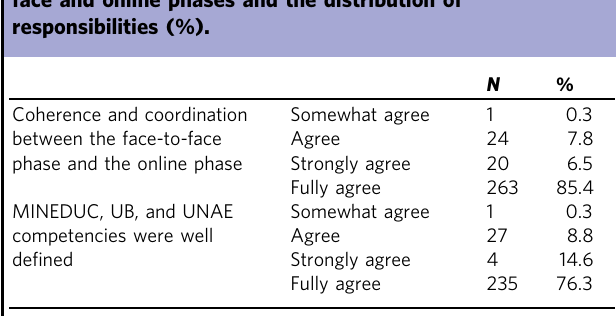
Table 3 Continuity and coordination between the face-to- face and online phases and the distribution of responsibilities (%).